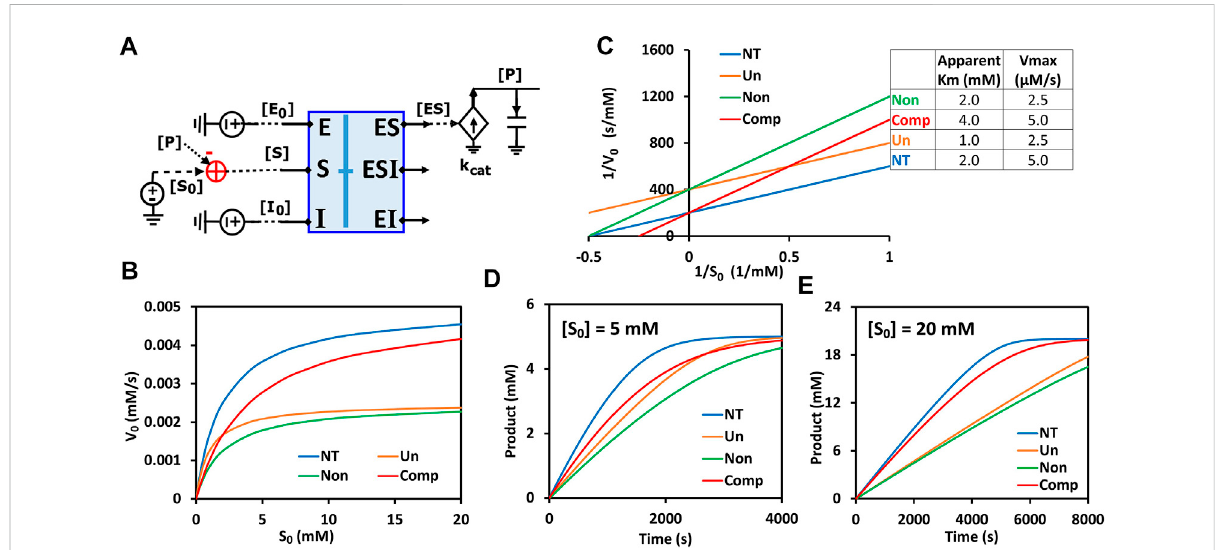
FIGURE 8 Generalized circuit simulations of enzymatic reactions with different inhibition types. The kinetic parameters used in the simulations are K m = 2 mM, K i = 3 mM, k cat = 500/s, E 0 = 10 nM, I 0 = 3 mM, with varying amounts of substrate S. (A) The simpli fi ed circuit schematic for the generalized inhibition circuit from Figure 7D with a binding block (blue box) and a catalytic reaction. The binding block is the same circuit used for the binding of enzyme, inhibitor, and substrate in Figure 7D, with a separated catalytic reaction block. (B) Simulation curves of initial reaction rate V 0 versus initialsubstrateconcentrationS 0 forenzymaticreactionswithoutinhibitor(NT),withanuncompetitiveinhibitor(Un),withanoncompetitiveinhibitor (Non), and a competitive inhibitor (Comp). (C) Lineweaver-Burk plot plotting 1/V 0 versus 1/S 0 . The inserted table corresponds to parameters derived from the X- and Y-intercepts of the corresponding line. These derived parameters exactly match the input parameters. (D,E) Predicted